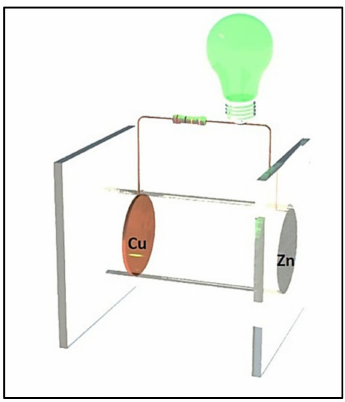
Figure 1. Scheme of the MFC